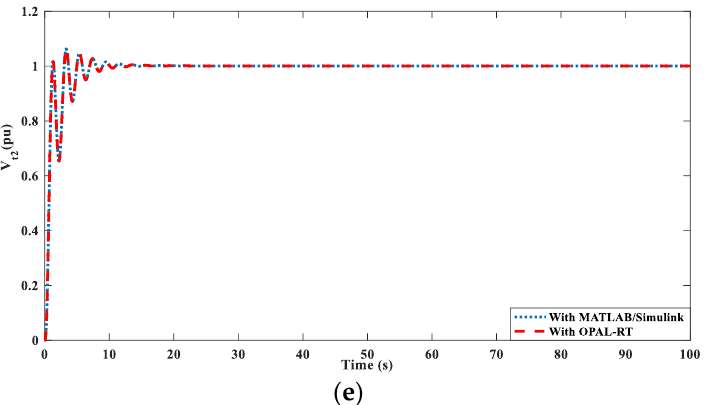
Figure 14. Validation of response through OPAL-RT OP4510: ( a ) ∆ f 1 ; ( b ) ∆ f 2 ; ( c ) ∆ P tie ; ( d ) V t1 ; ( e ) V t2 .